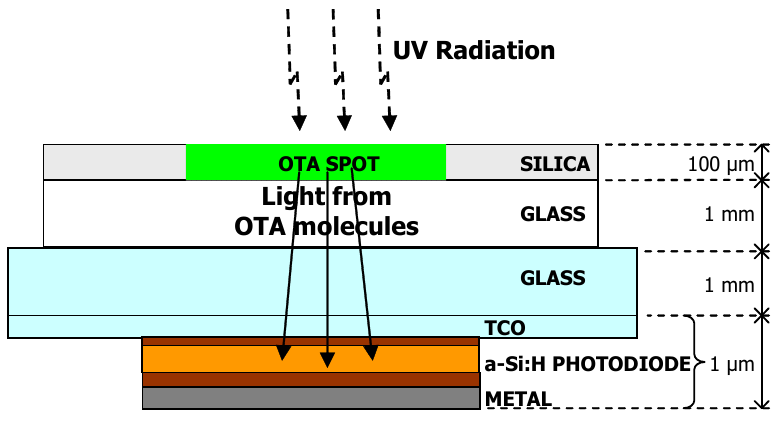
Figure 1. Schematic view of the proposed system for OTA detection. The a-Si:H photodiode is a p-i-n stacked junction.